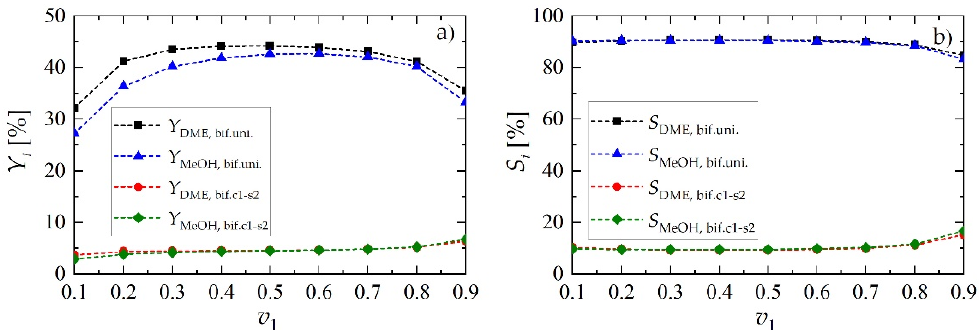
Figure 8. Yield and selectivity of methanol and dimethyl ether for bifunctional pellets as a function of the volume fraction occupied by metallic sites, v 1 , for R p = 1.5 mm and u in = 0.05 m · s − 1 : ( a ) yield of DME and MeOH; ( b ) selectivity toward DME and MeOH.